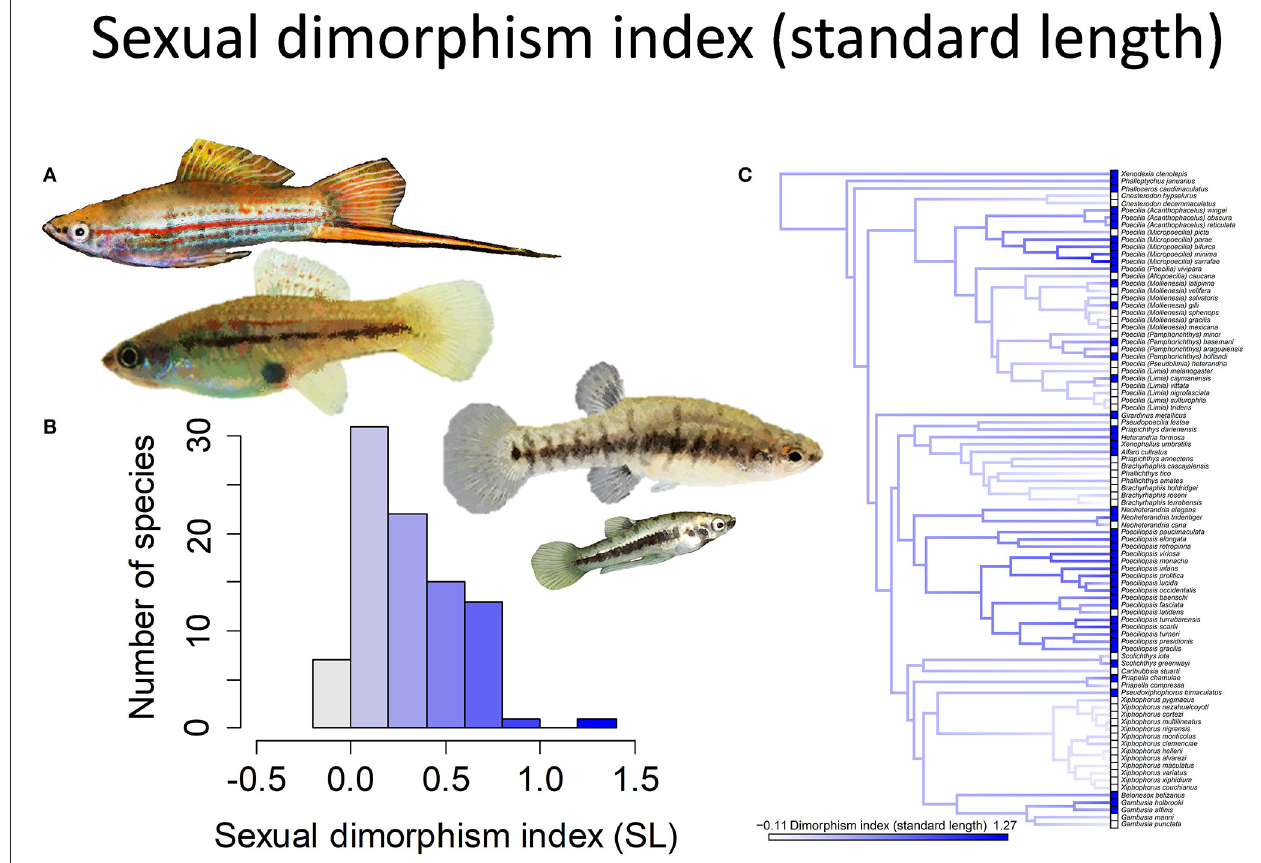
FIGURE 1 | The magnitude of sexual size dimorphism (standard length) in the family Poeciliidae ranges from − 0.11 to 1.27. Zero indicates males and females are of equal size, negative values males larger than females, and positive values females larger than males. (A) Xiphophorus hellerii males and females are of approximately equal size (pictured left) while males are considerably smaller than females in Heterandria formosa (pictured right). (B) Frequency histogram of the sexual dimorphism index ( n = 90). (C) Ancestral state reconstruction of the sexual dimorphism index as a continuous character using the contMap function in the R package phytools, which estimates the Maximum likelihood ancestral states at all internal nodes and interpolates the states along each edge. The phylogeny tips depict a binary categorization of the size dimorphism index (i.e., low vs. high). The most likely ancestral state of the family, when treated as a binary character, is that of a high degree of size dimorphism (Furness et al.,